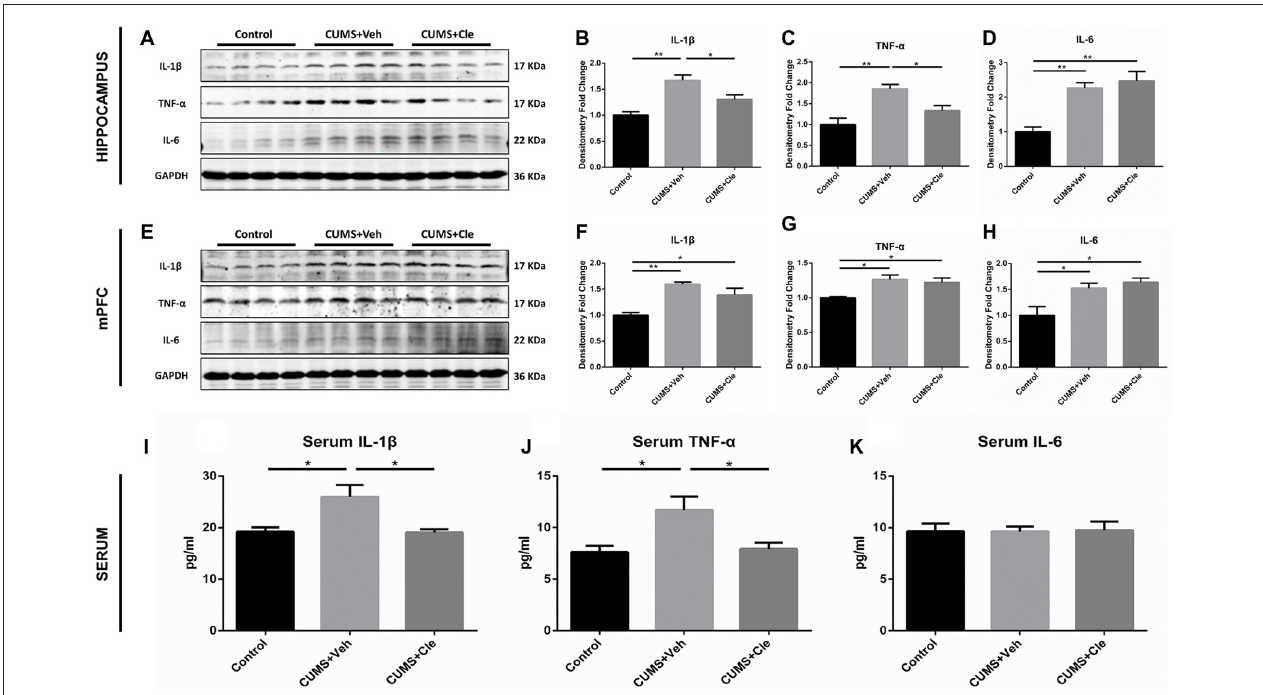
FIGURE 3 | Detections of pro-inflammatory cytokines in hippocampus, medial prefrontal cortex (mPFC) and serum. (A–D) In the hippocampus, CUMS treatment resulted in higher levels of proinflammatory cytokines including interleukin-1 beta (IL-1 β ), tumor necrosis factor alpha (TNF- α ) and interleukin-6 (IL-6). Continuous intervention of clemastine injection decreased the protein levels of both IL-1 β and TNF- α . (E–H) In the mPFC area, manipulation of chronic stress coincidentally brought about elevated expressions of IL-1 β , TNF- α and IL-6. Nevertheless, clemastine failed to modulate the upregulation of the aforementioned cytokines. (I–K) In serum samples, chronic mild stress (CMS) moderately elevated the concentrations of IL-1 β and TNF- α rather than regulated IL-6 levels. Besides, clemastine remarkably cut down the amounts of IL-1 β and TNF- α ( n = 4 for (A–H) n = 5–6 for (I–K) , ∗ p < 0.05, ∗∗ p <